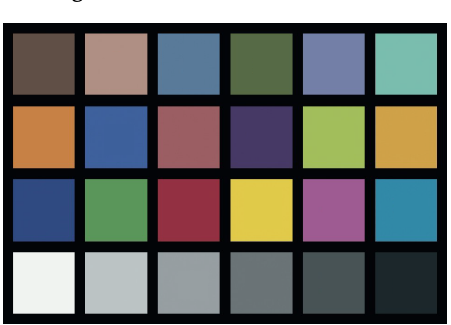
Figure 6. Architecture of the ANN.